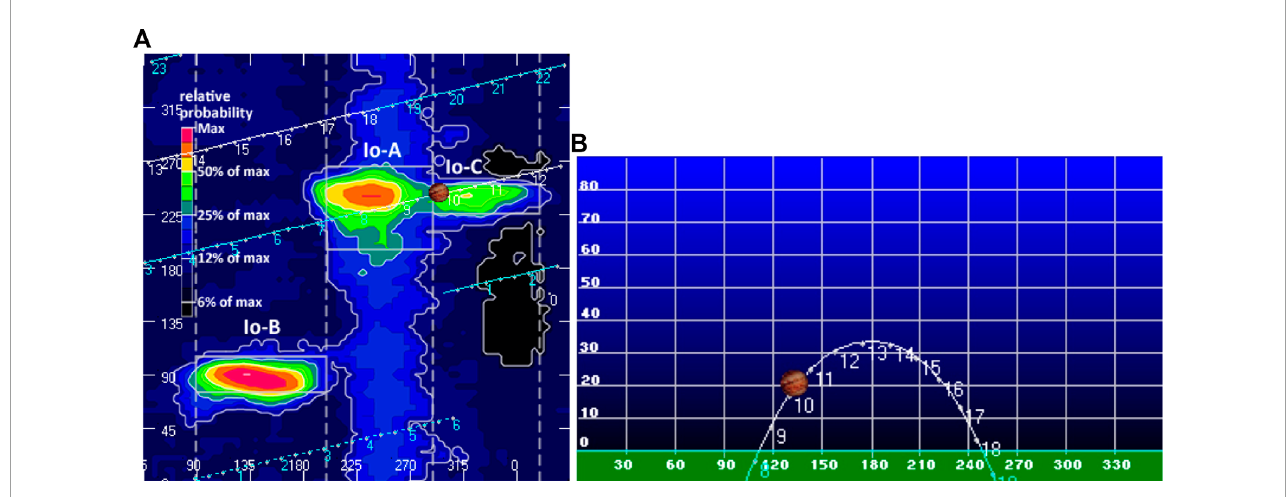
FIGURE 2 Radio Jupiter Pro features: (A) Io Phase-CML probability map with the observer’s location marked with the Jupiter planet symbol; (B) elevation of Jupiter at the location of the observer. Tick marks are labelled every hour on the tracks of Jupiter on each panel.